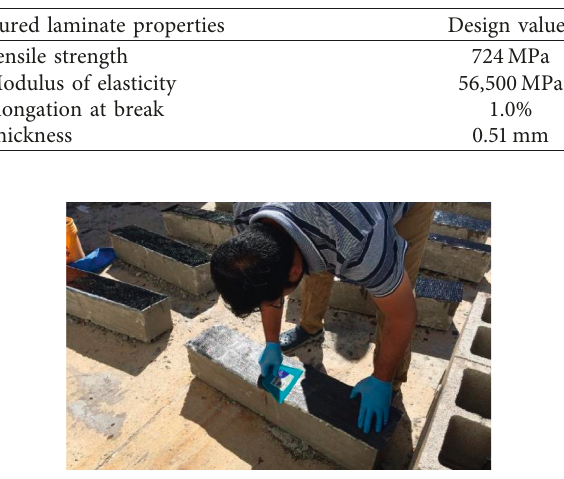
Figure 3: Application of the CFRP laminate.